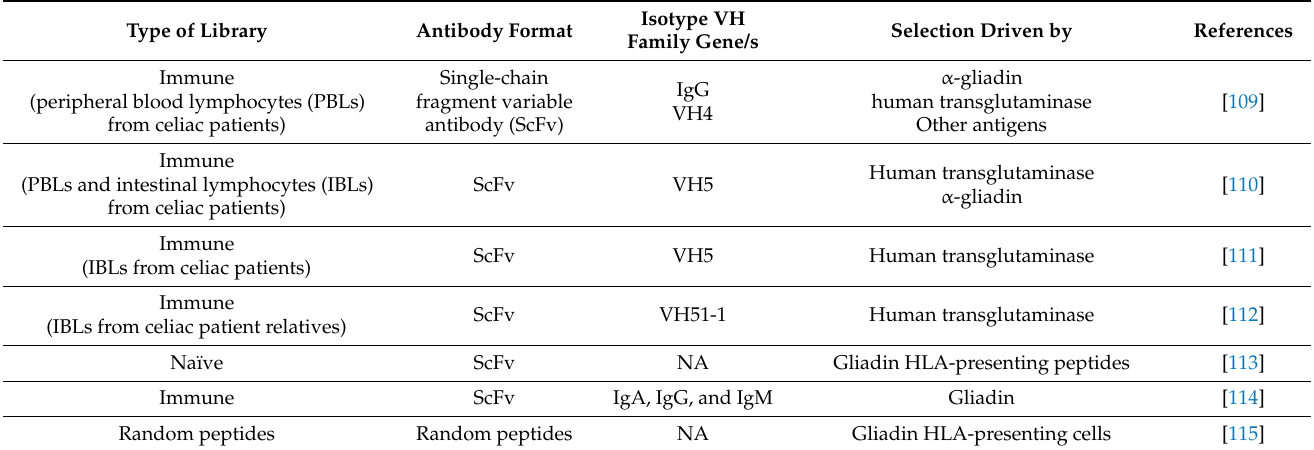
Table 4. Several examples of phage display technology applied to celiac disease research.